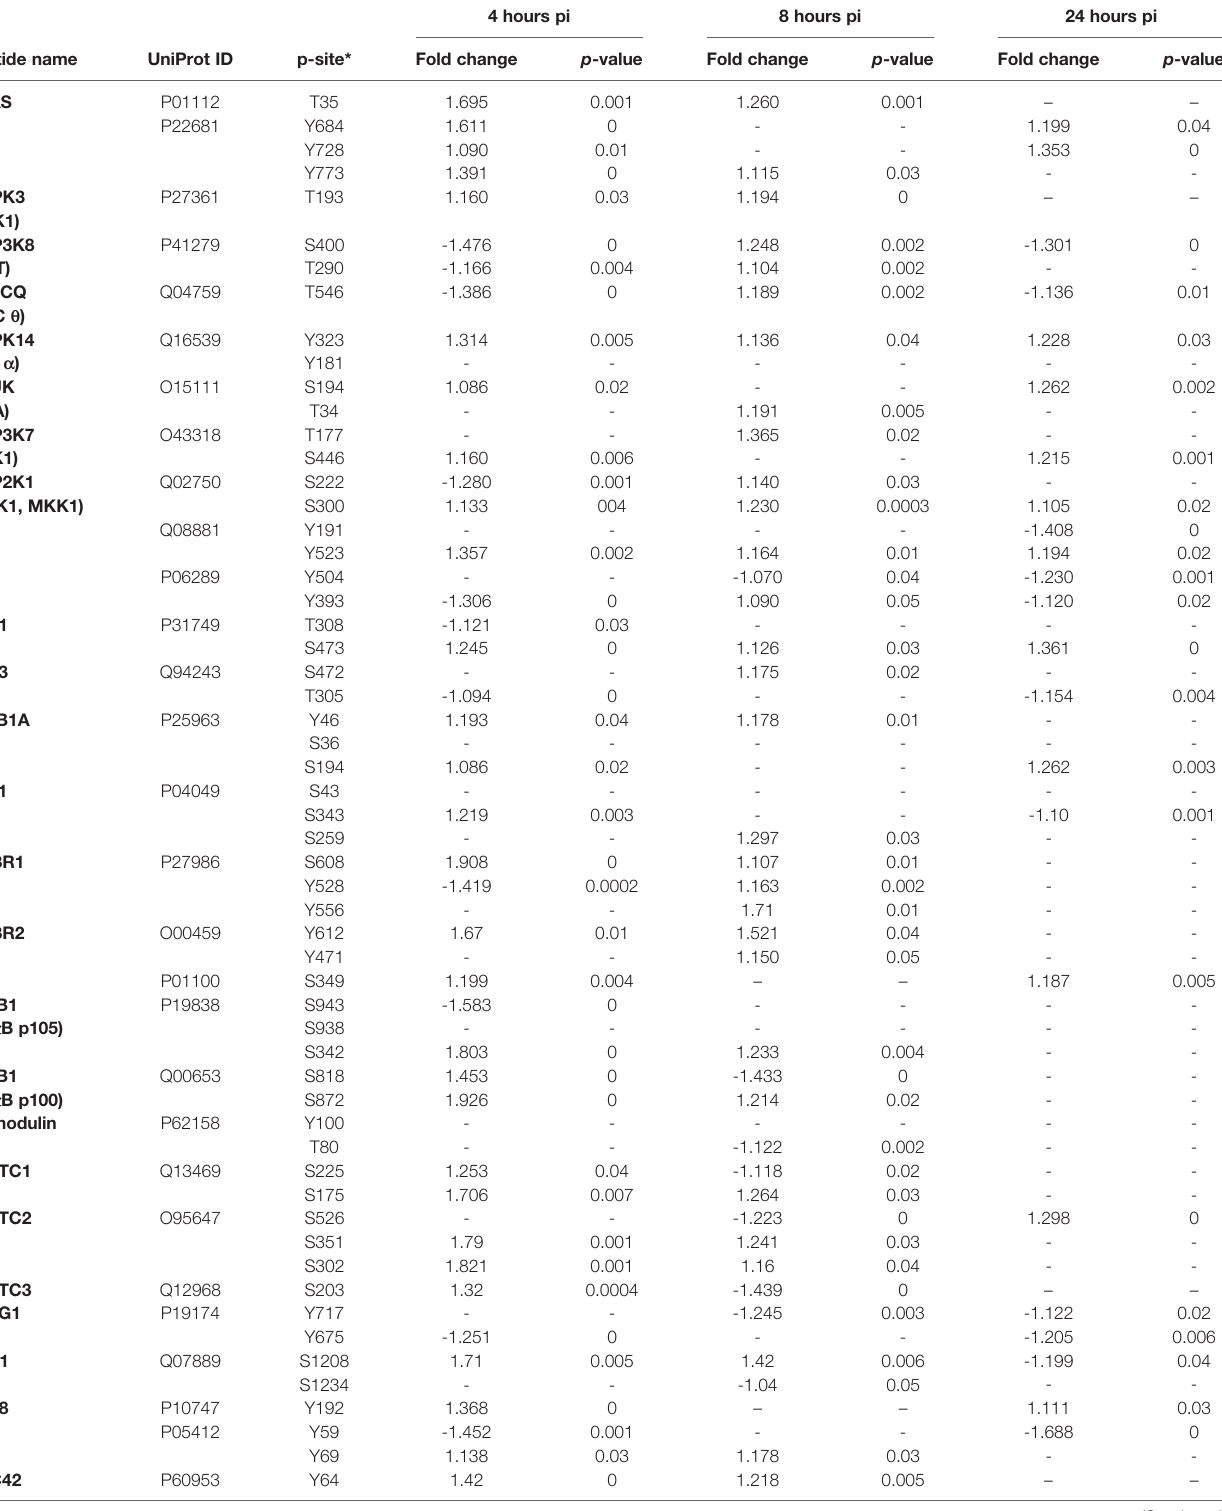
TABLE 9 | Members of the T cell receptor signaling pathway showing differential phosphorylation between Salmonella enterica serovar Enteritidis-infected cecal tissue and non-infected cecal